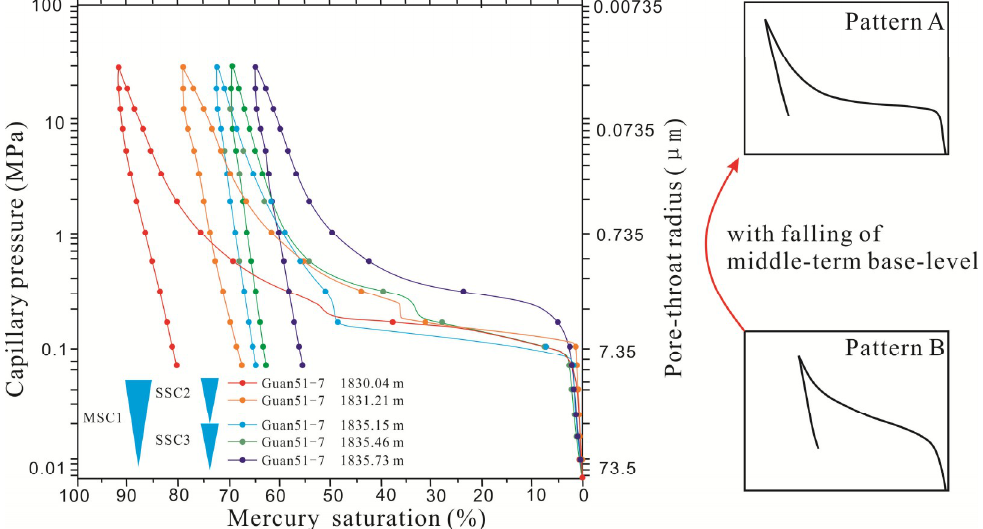
Figure 13. Intrusion and extrusion curves of PMI of the samples in MSC1.